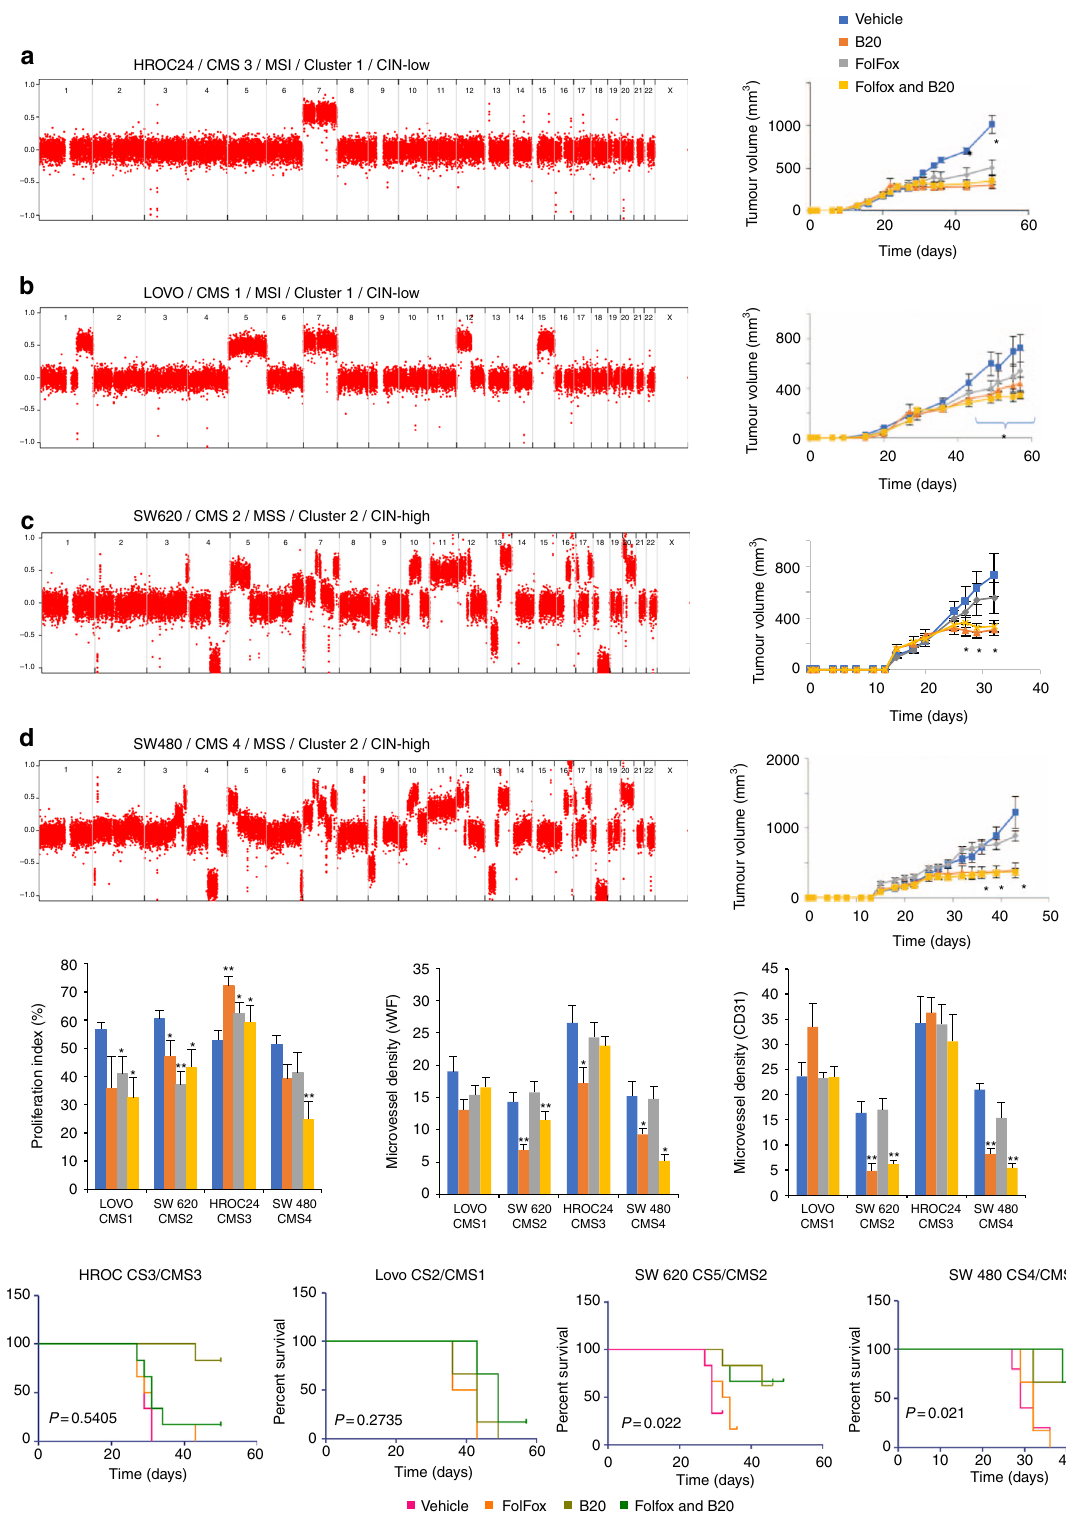
Fig. 8 In vivo experiments and IHC analyses on xenografts. a – d Whole-genome copy number pro fi le and growth curves of xenografts and analysis of the tumor sizes for four out of the seven cell lines. Error bars represent s.e.m. of six animals per group. Student's t -test * p < 0.05. e Immunohistochemical staining to determine the proliferation index (Ki67) and microvessel densities (vWF and CD31). Error bars represent s.e.m. Student ’ s t -test * p < 0.05, ** p < 0.01. f KM-plots for PFS based on modi fi ed RECIST criteria. Regression was de fi ned as a 50% decrease in tumor size and progression as a 35% increase in tumor